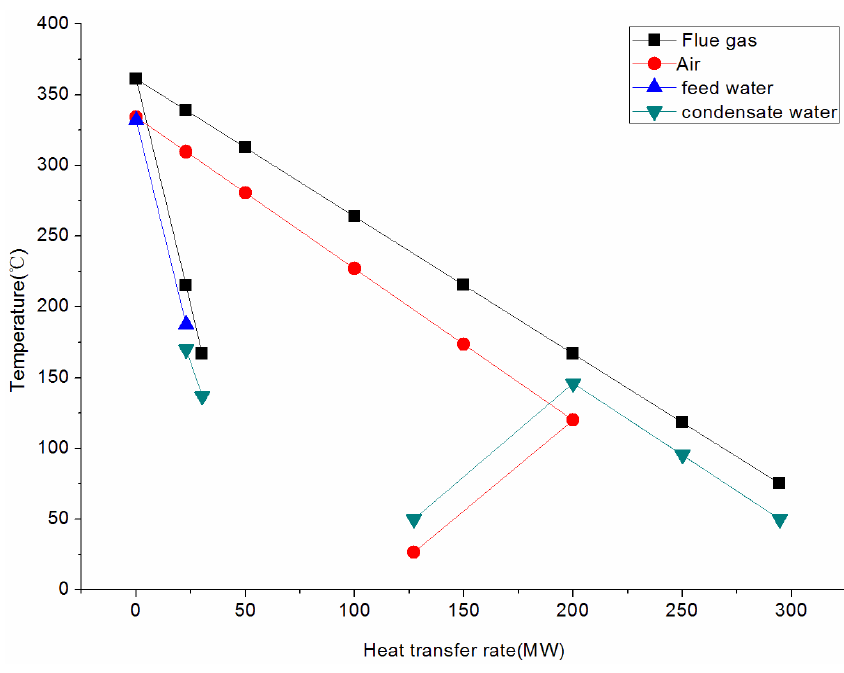
Figure 5. Comprehensive heat transfer curve of new system. Table 4. Thermal parameters of heat exchange equipment at the tail of the boiler.